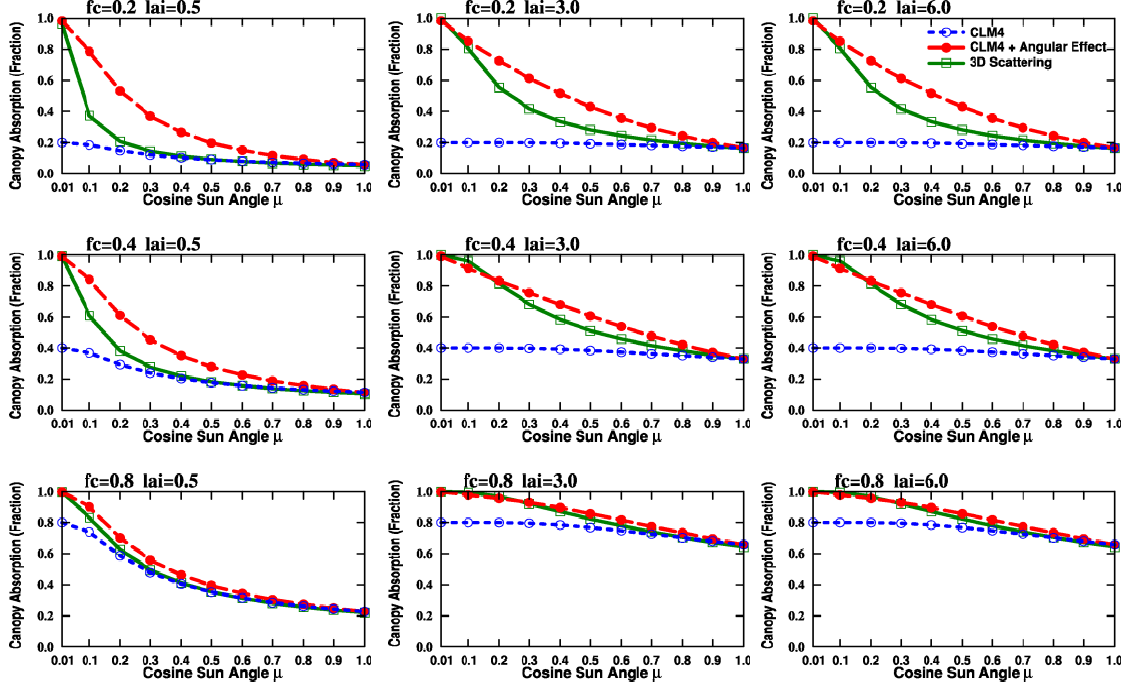
Figure 11. FPAR in relation to µ . Blue lines show simulations from the 2-stream solution in the CLM4 (blue), red lines show simulations from the proposed solution in the paper and green lines show simulations from the 3D scattering model at = 0.2, 0.4 and 0.8 and LAI = 0.5, 3.0 and